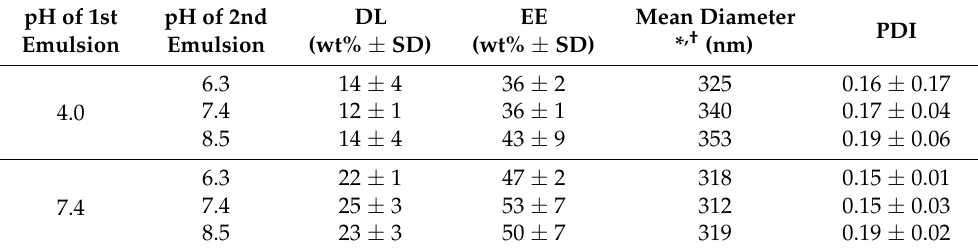
Table 2. Effect of the pH of VCM solution (inner aqueous phases, 1st emulsion) and of the suspension medium containing NaCl and the emulsifier PVA (outer aqueous phases, 2nd emulsion) on the incorporation of VCM and PLGA 15 C NP size and